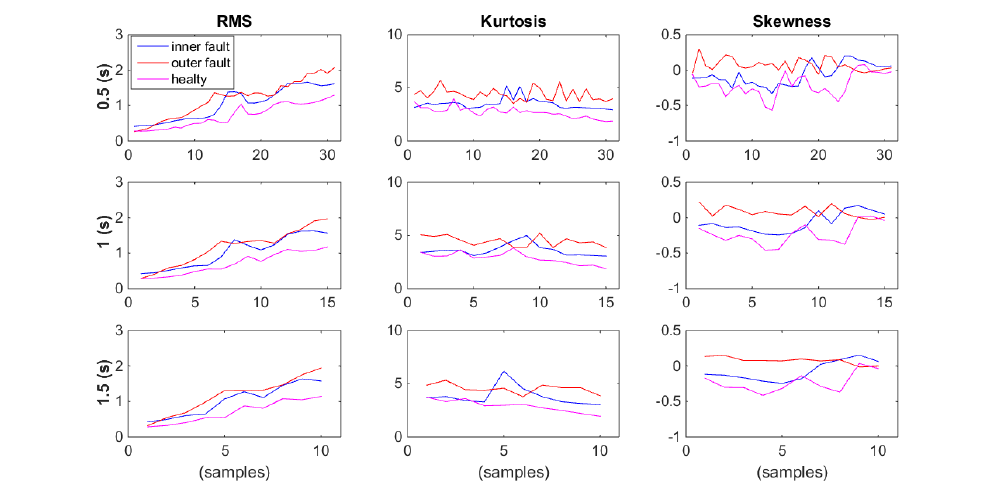
Figure 8. Variations of feature values for different duration of data input for polynomial speed tests.